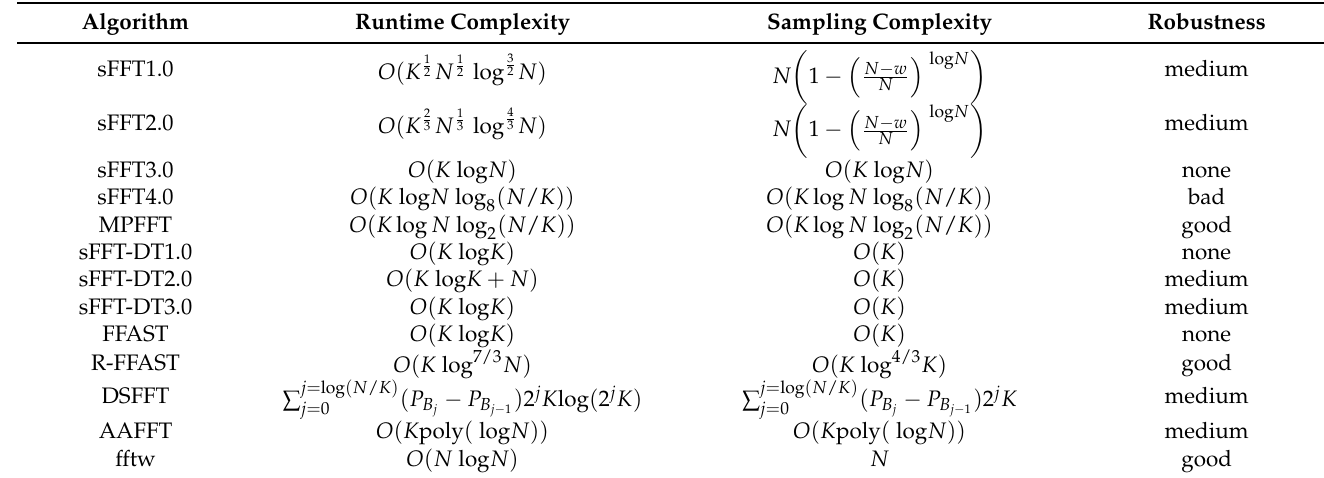
Table 2. The performance of fftw algorithm and sFFT algorithms in